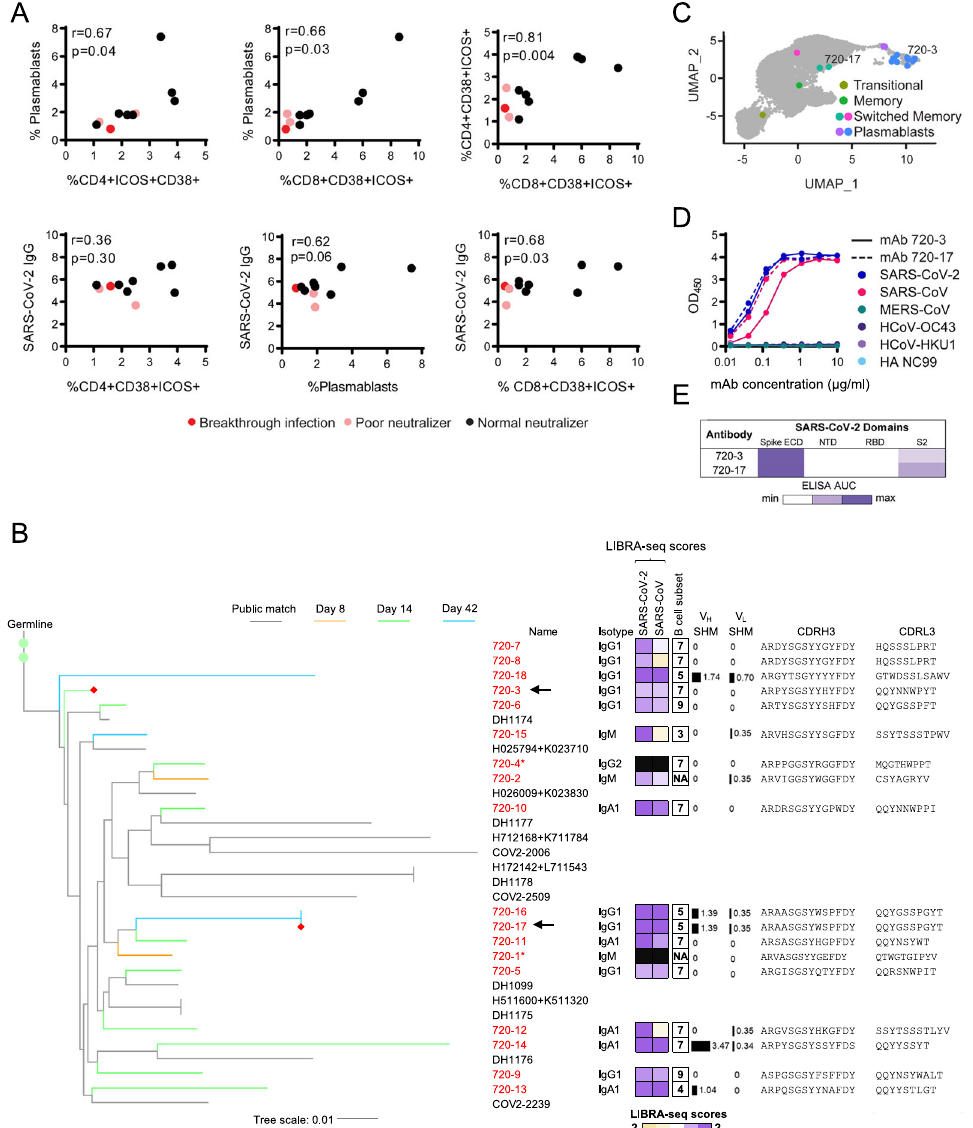
Fig. 8 Associations of antigen-speci fi c cell populations and antibody responses. A Correlation of biaxially gated plasmablast and T-cell populations with other cellular subsets from CyTOF analyses in Figs. 2 and 4 with SARS-CoV-2 IgG using Pearson correlations. Patients with typical neutralization titers are shown in black, poor neutralizers with no known breakthrough infection are shown in pink, and a poor neutralizer with known breakthrough infection is shown in red. B Phylogenetic tree of a public antibody cluster comprised of LIBRA-seq-identi fi ed sequences (antibody names: red; branches: colored by timepoint) and previously published SARS-CoV-2 antibody sequences from the CoV-AbDab database (gray), with recombinantly expressed antibodies 720-3 and 720-17 highlighted with a red diamond at the end of their respective branches and arrows. For each sequence from the cluster, sequence features including isotype, LIBRA-seq scores, % SHM of V-gene, and amino acid sequences of CDRH3 and CDRL3 are displayed. Nucleotide level percentage of SHM changes of V-genes of both heavy and light chains were reported as bars with numerical values. LIBRA-seq scores are shown as a range with tan-white-purple representing -2 to 0 to 2. Scores higher or lower than this range are shown as − 2 and 2, respectively. The B-cell subsets are classi fi ed by scRNA-seq analysis. Sequences denoted by an asterisk (720-1 and 720-2) did not ful fi ll the cutoff for RNA-seq analysis and therefore were not classi fi ed into a B-cell subset. Antibodies 720-1 and 720-4 do not have a computed LIBRA-seq score due to not meeting data fi ltering criteria, as described in the methods. C Location of B cells in cluster 720 including recombinantly expressed monoclonal antibodies (720-3 and 720-17) on UMAP identi fi ed clusters of B cells based on transcriptional similarity. D ELISAs for antibodies selected for monoclonal antibody characterization are shown against spike proteins for SARS-CoV-2 (blue), SARS-CoV (pink), MERS-CoV (teal), HCoV-OC43 (purple), HCoV-HKU1 (light purple), and HA NC99 (light blue) for antibodies 720-3 (solid lines) and 720-17 (dashed lines). E Epitope mapping ELISA AUC for antibodies 720-3 and 720-17 against SARS-CoV-2 spike ECD, and truncated subunit domains NTD, RBD, and S2. ELISAs were performed in technical duplicate and repeated serum): CD8a e450 (Invitrogen 48-0086-42, 1:200) ICOS BV605 (Biolegend 313538, 1:50), CCR7 PE (Biolegend 353204, 1:200), CD38 PerCP (Biolegend 1:200) and PD-1 PE (Biolegend 135205, 1:100). CD71 APC (Biolegend 334108,